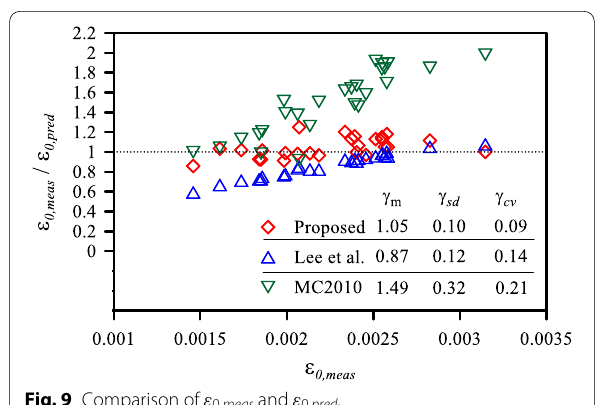
Fig. 9 Comparison of ε 0, meas and ε 0, pred